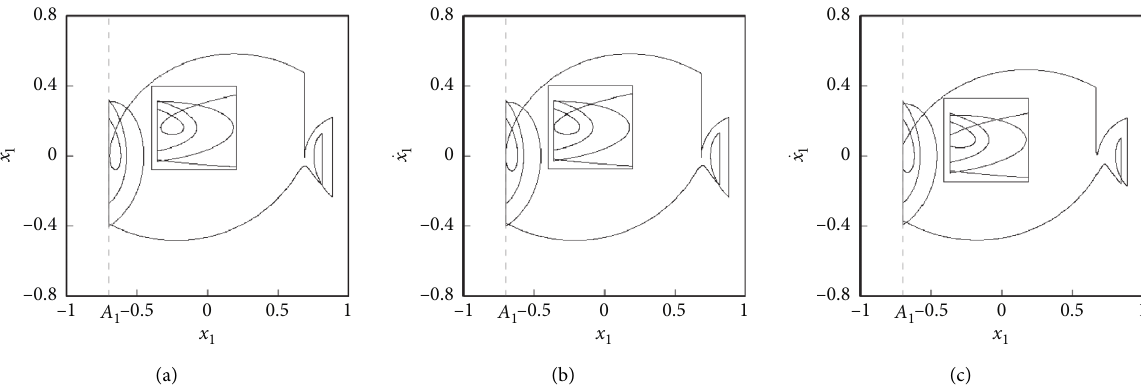
Figure 5: Phase portraits of mass M , δ � 0.7: (a) 1-3-3 motion with ω � 0.3149, (b) 1-3-3 grazing contact with ω � 0.3147, and (c) 1-3-4 1 motion with ω �